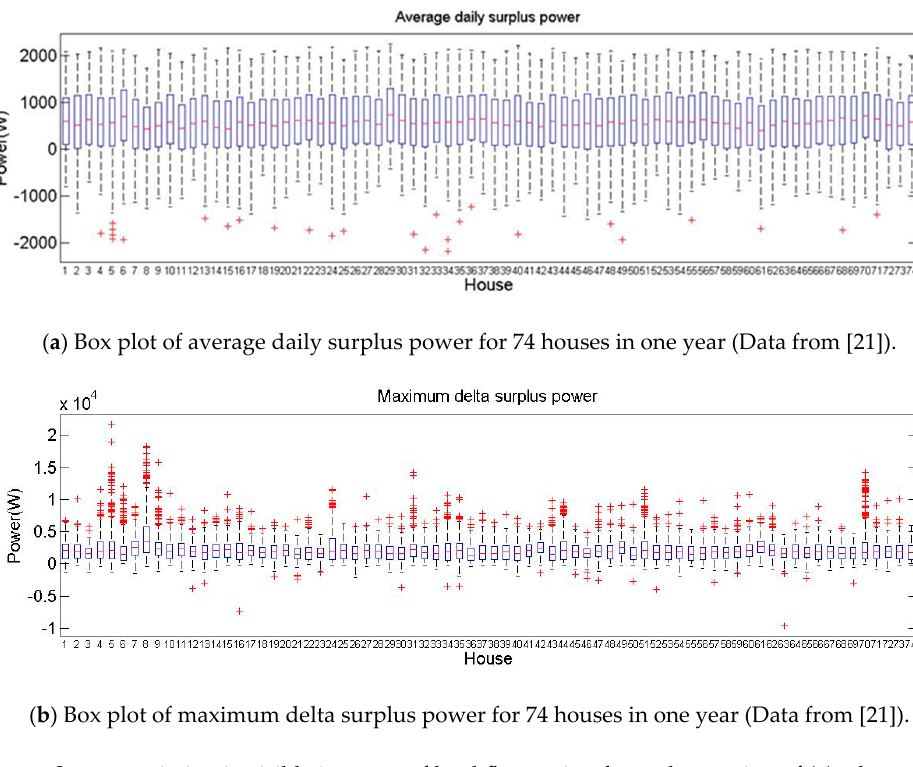
Figure 2. Strong variation is visible in terms of load fluctuation from observation of ( a ) a long time interval of one day, and from ( b ) a short time interval of 10 min.